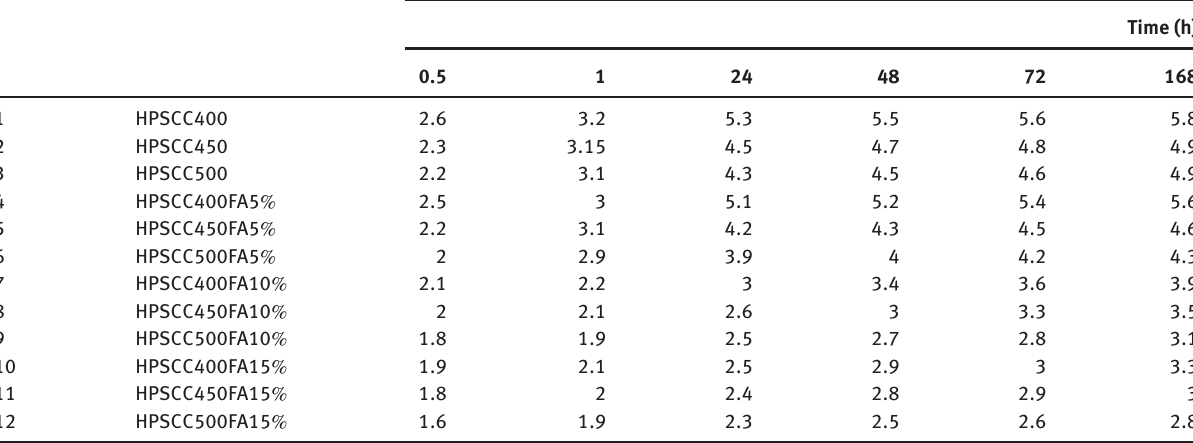
Table 9 Results of water absorption by time.